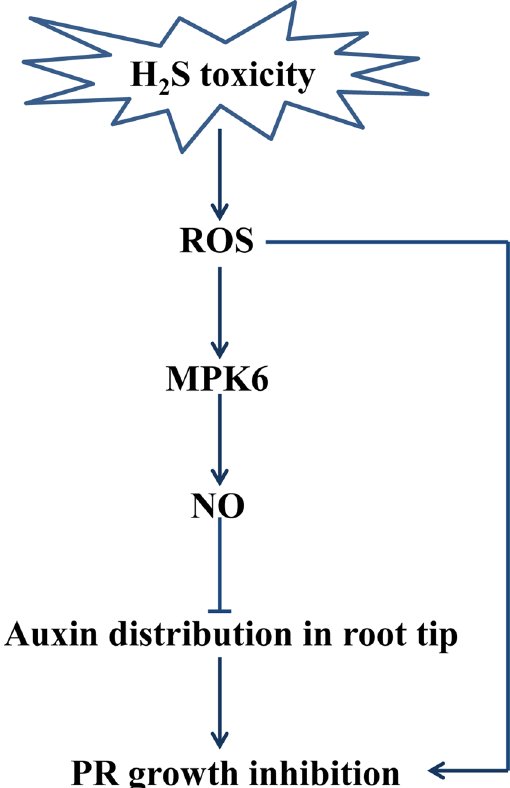
Figure 8. H 2 S toxicity inhibits PR growth via the ROS-MPK6-NO signaling pathway. High-concentration H 2 S induced ROS production via the NADPH oxidase pathway, which directly inhibited PR growth and activated MPK6. MPK6 then promoted NO production through both L-Arg-dependent and NR-dependent routes. Elevated NO repressed auxin distribution, ultimately inhibiting PR